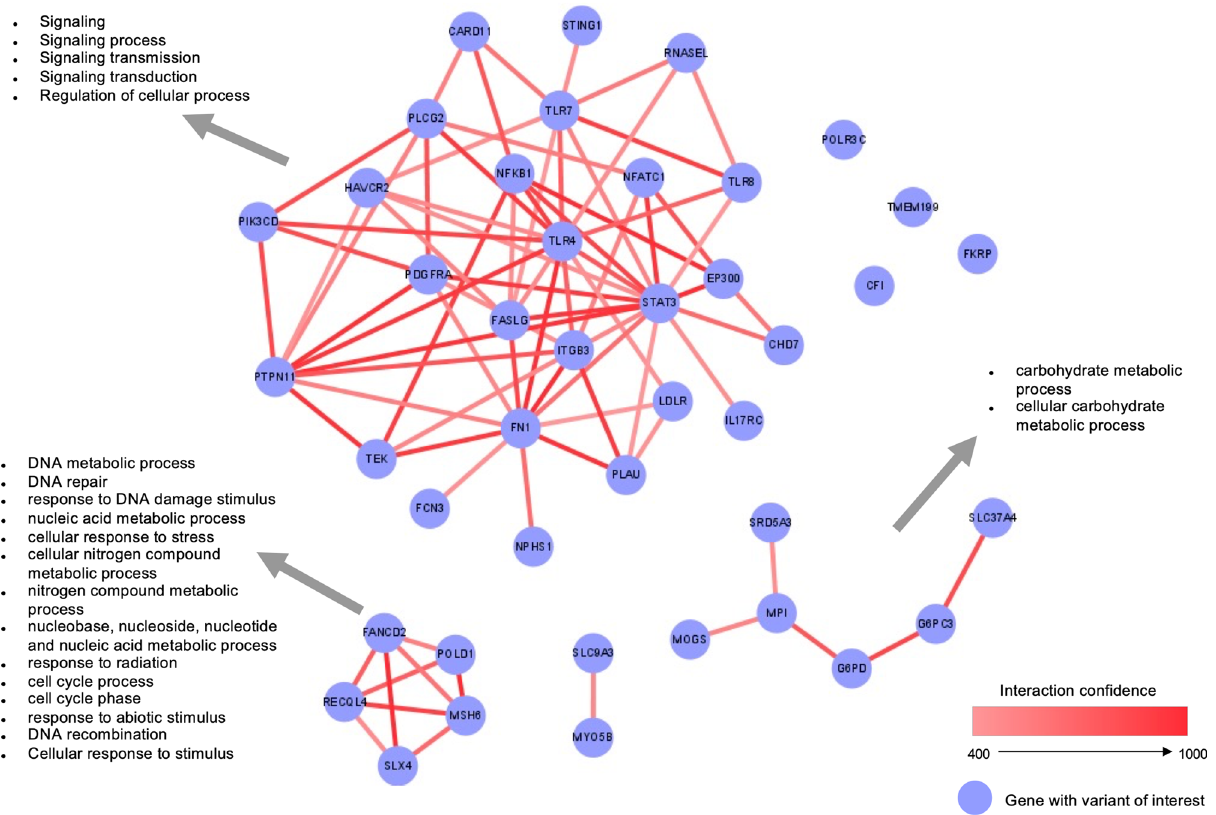
Figure 2. Network analysis of the genes with candidate